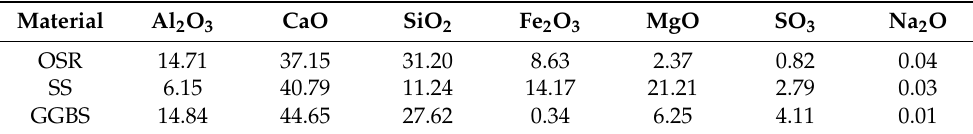
Table 3. Main chemical compositions of raw materials by XRF analysis (wt %).